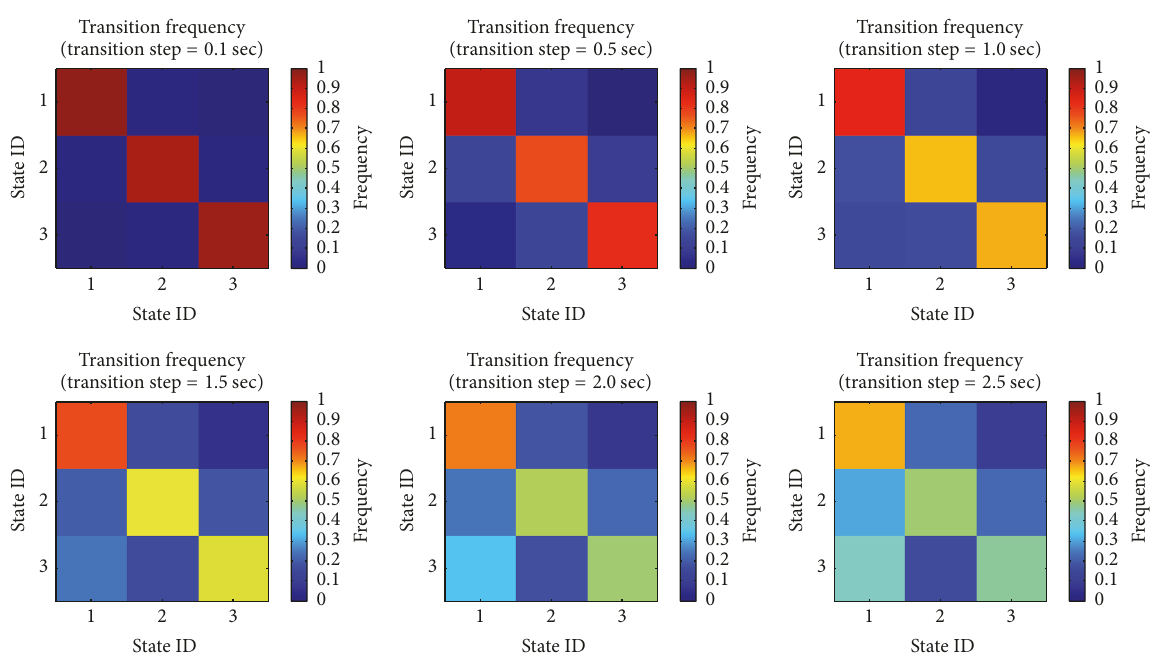
Figure 5: Driving risk state transition pattern (TW = 1.0s).